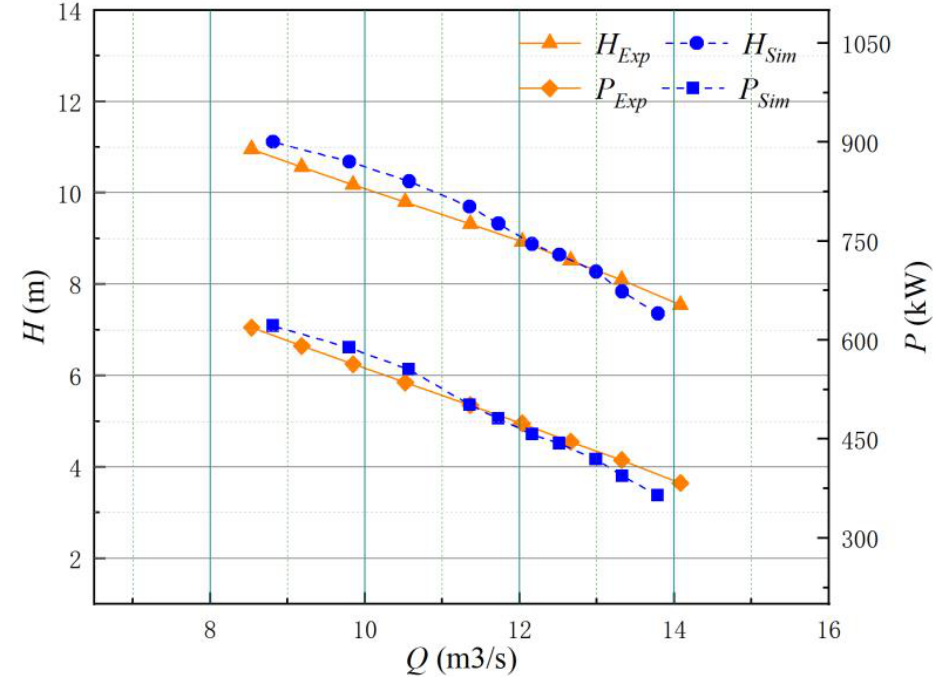
Figure 6. Energy characteristics of LAPS.